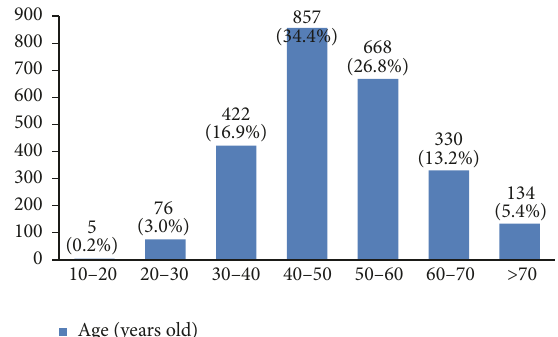
Figure 1: The sex distribution of the studied breast cancer patients. Figure 2: The age groups of the studied breast cancer cases.